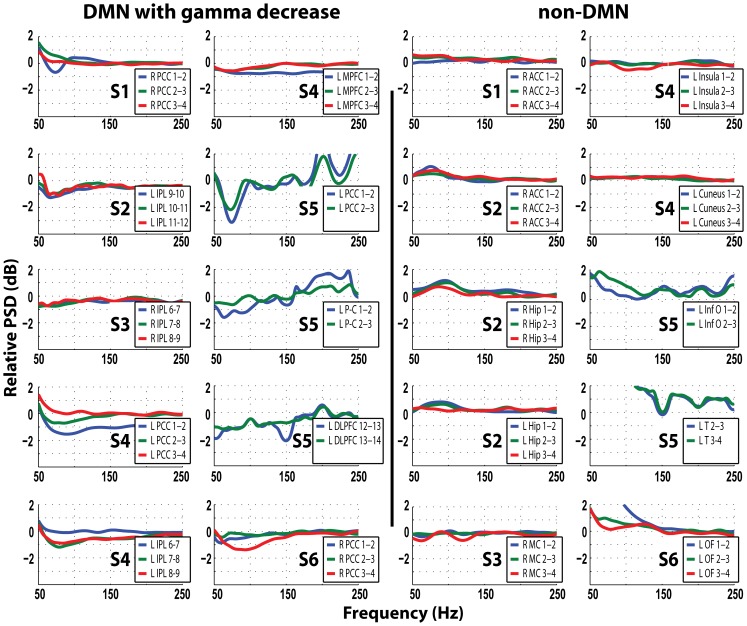
Relative power spectral density in dB, for frequencies 50–250 Hz.Power spectra in the DMN regions with gamma decrease and the non-DMN regions in all patients comparing 1 s epochs at the center of IED to baseline. Blue trace is the most medial, followed laterally by the green and red traces. S1–S6 relates to patients 1–6. Note the consistency of gamma decrease in DMN regions and the lack of similar spectral changes in non-DMN contacts.